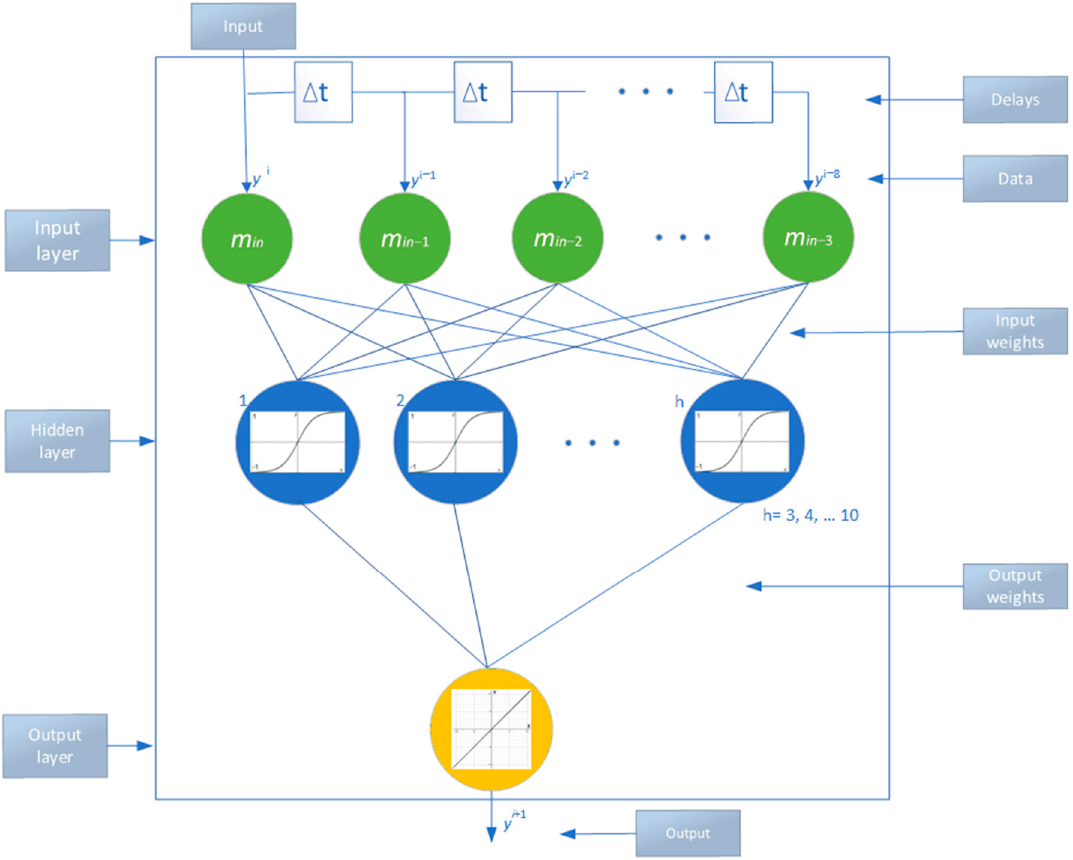
Figure 3. Time Delay Neural Network basic cell.